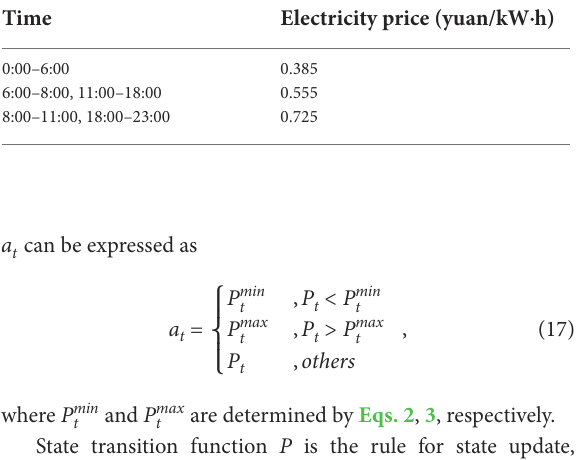
TABLE 1 Time-of-use electricity